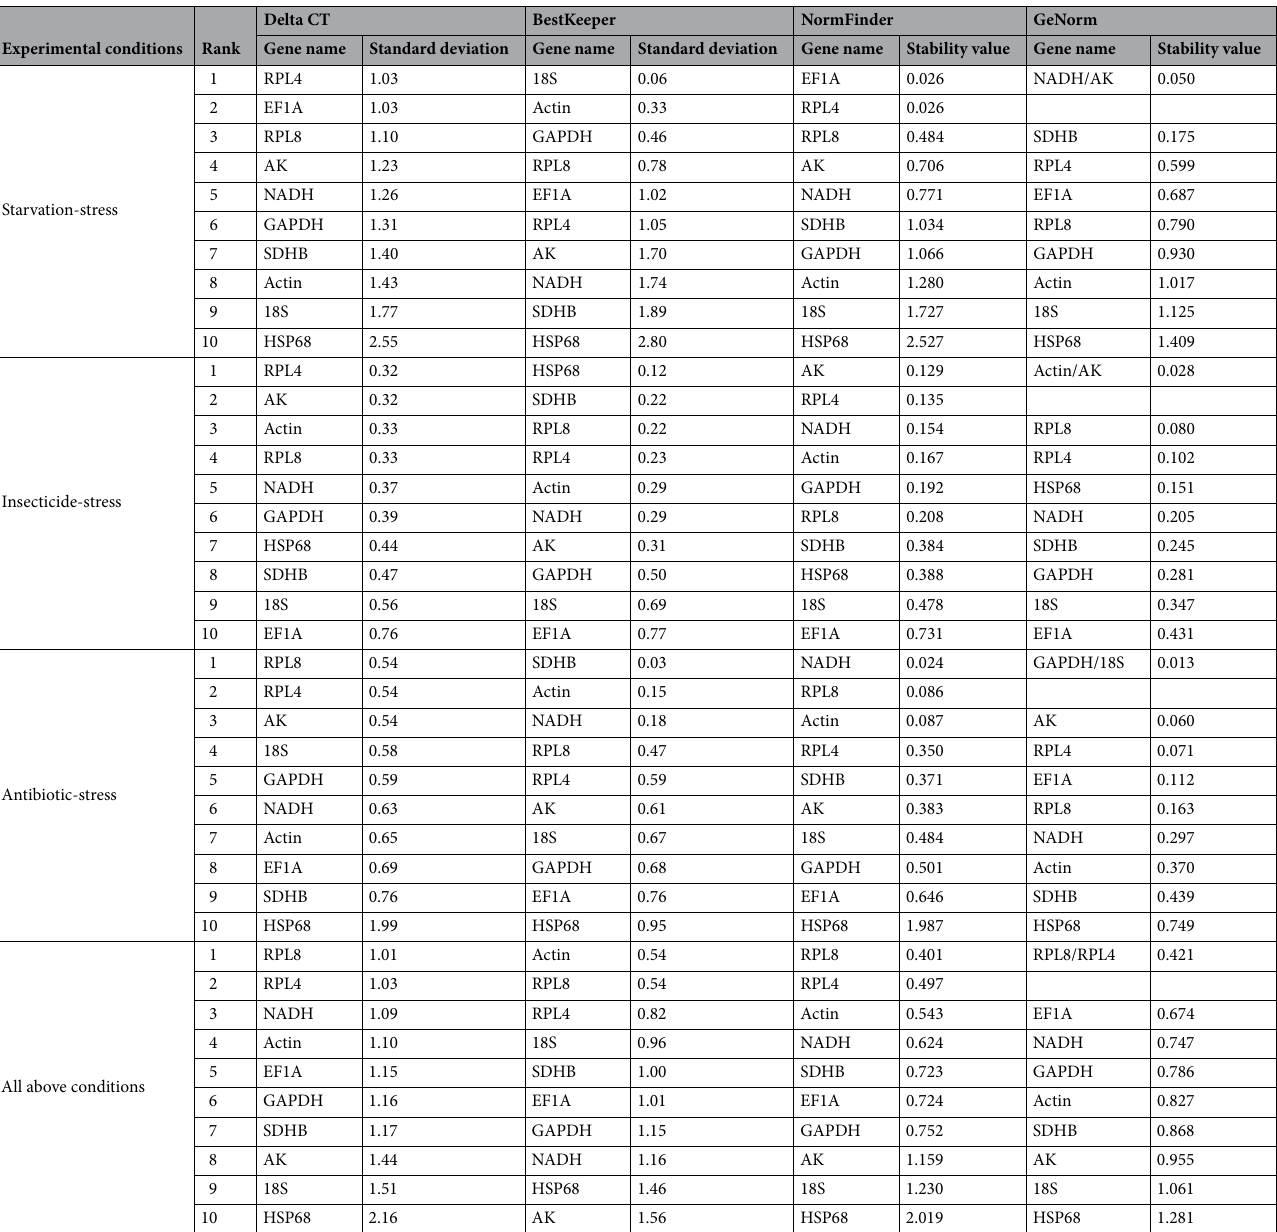
Table 1. Rank order of the M. dirhodum candidate reference genes under various experimental